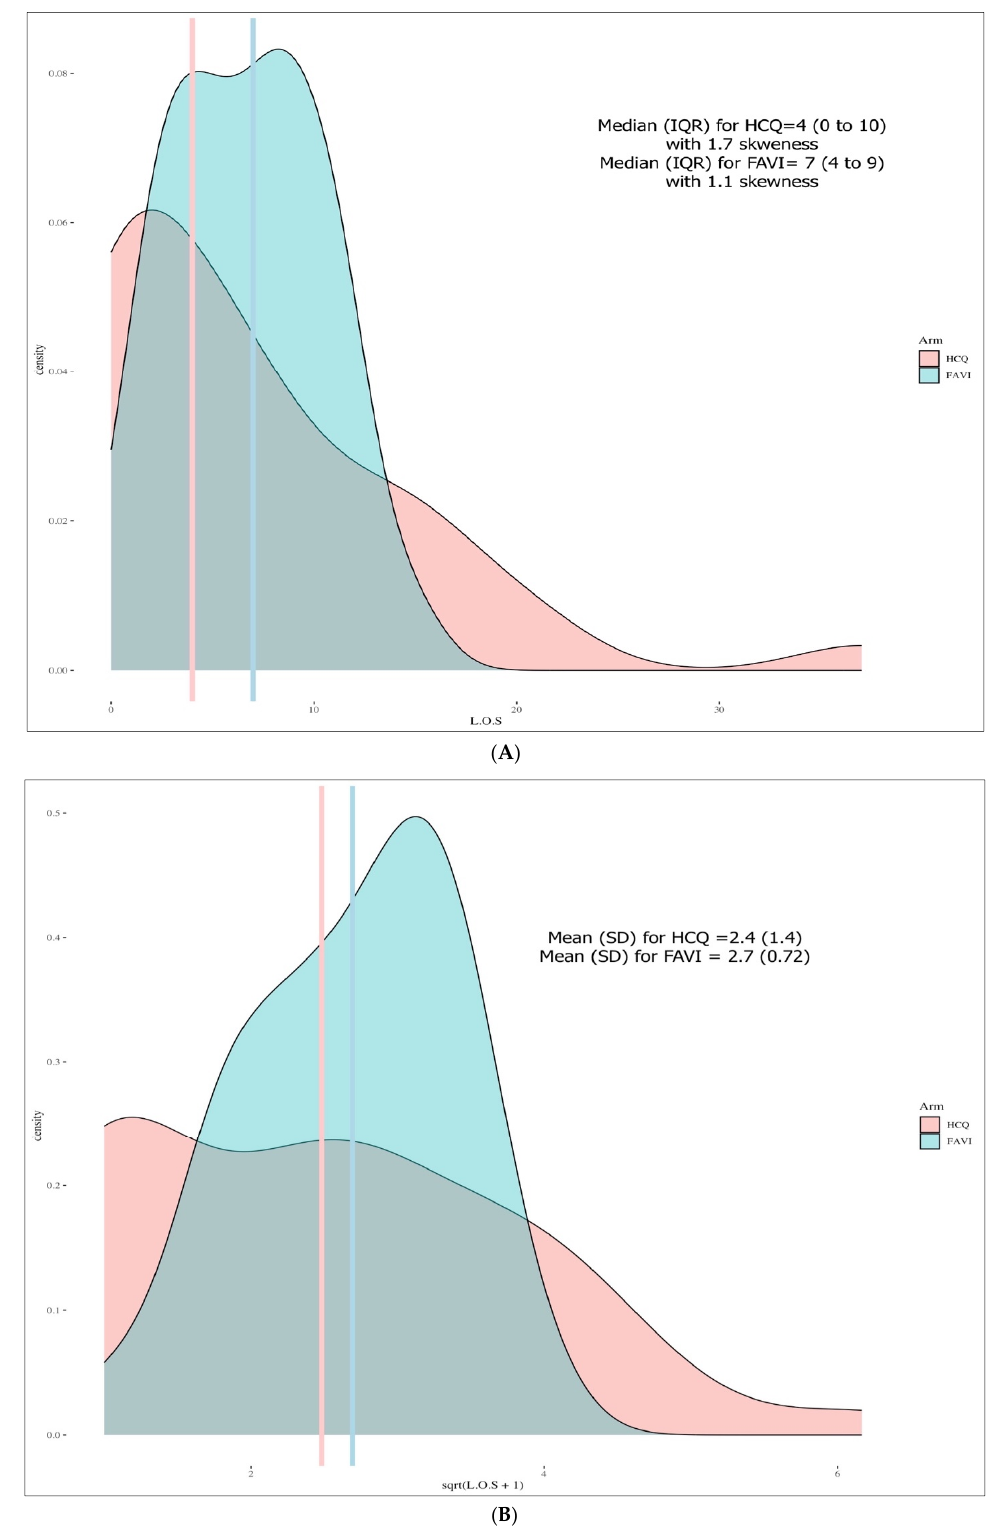
Figure 1. ( A ). Length of stay (LOS) density plot for the matched sample. Median presented for each group with the interquartile range (IQR). ( B ). square root length of stay (LOS) + 1-day density plot for the matched sample. Mean with the standard deviation (SD) presented for each group. HCQ = hydroxychloroquine. FAVI = Favipiravir. Vertical line for Figure 1A indicates median and Figure 1B are mean.